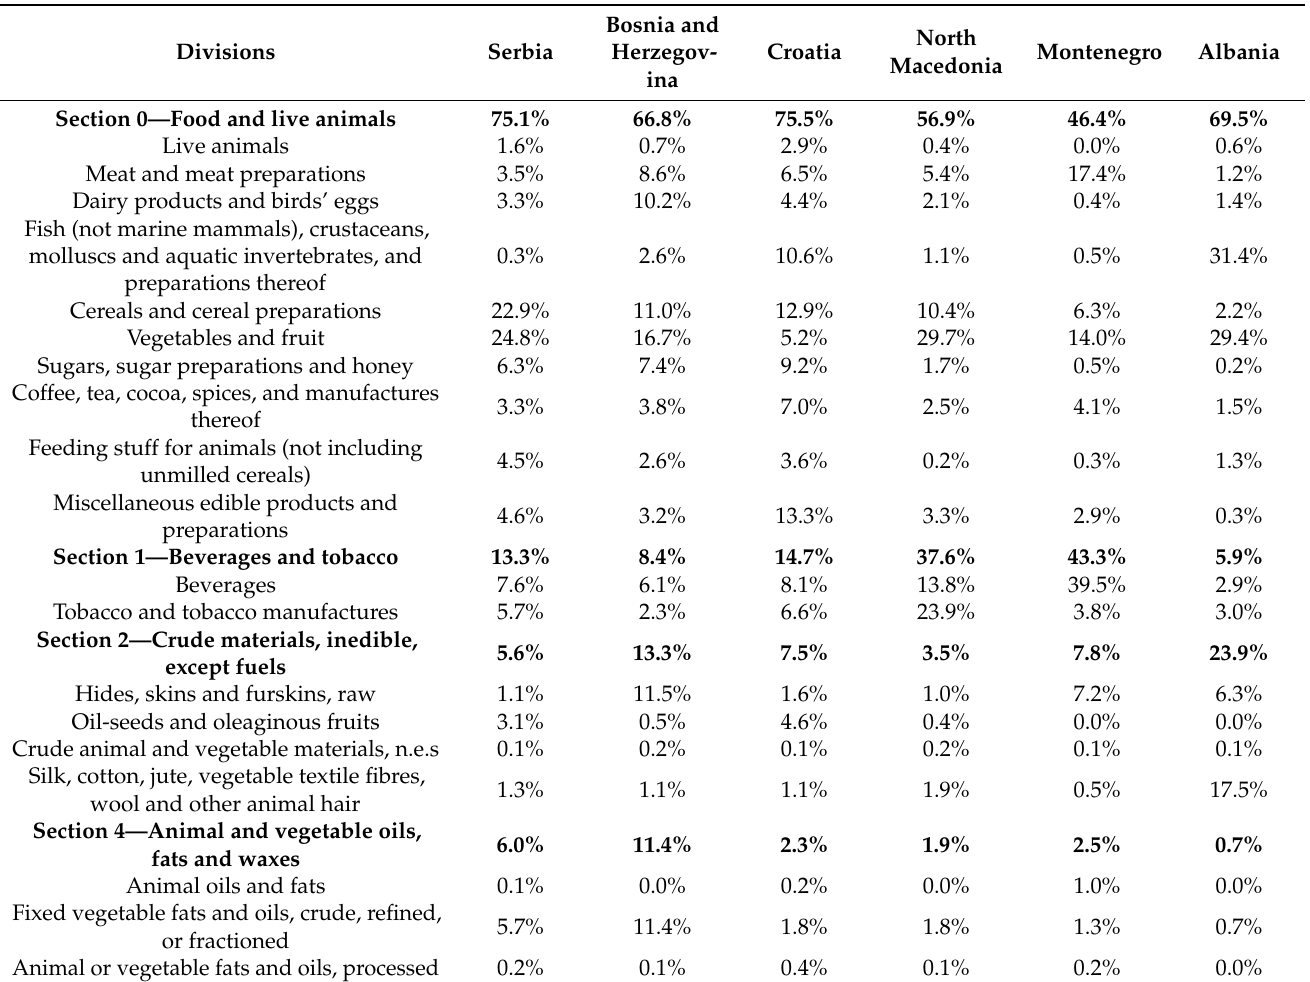
Table 1. Commodity structure of export of agri-food sector of the WB